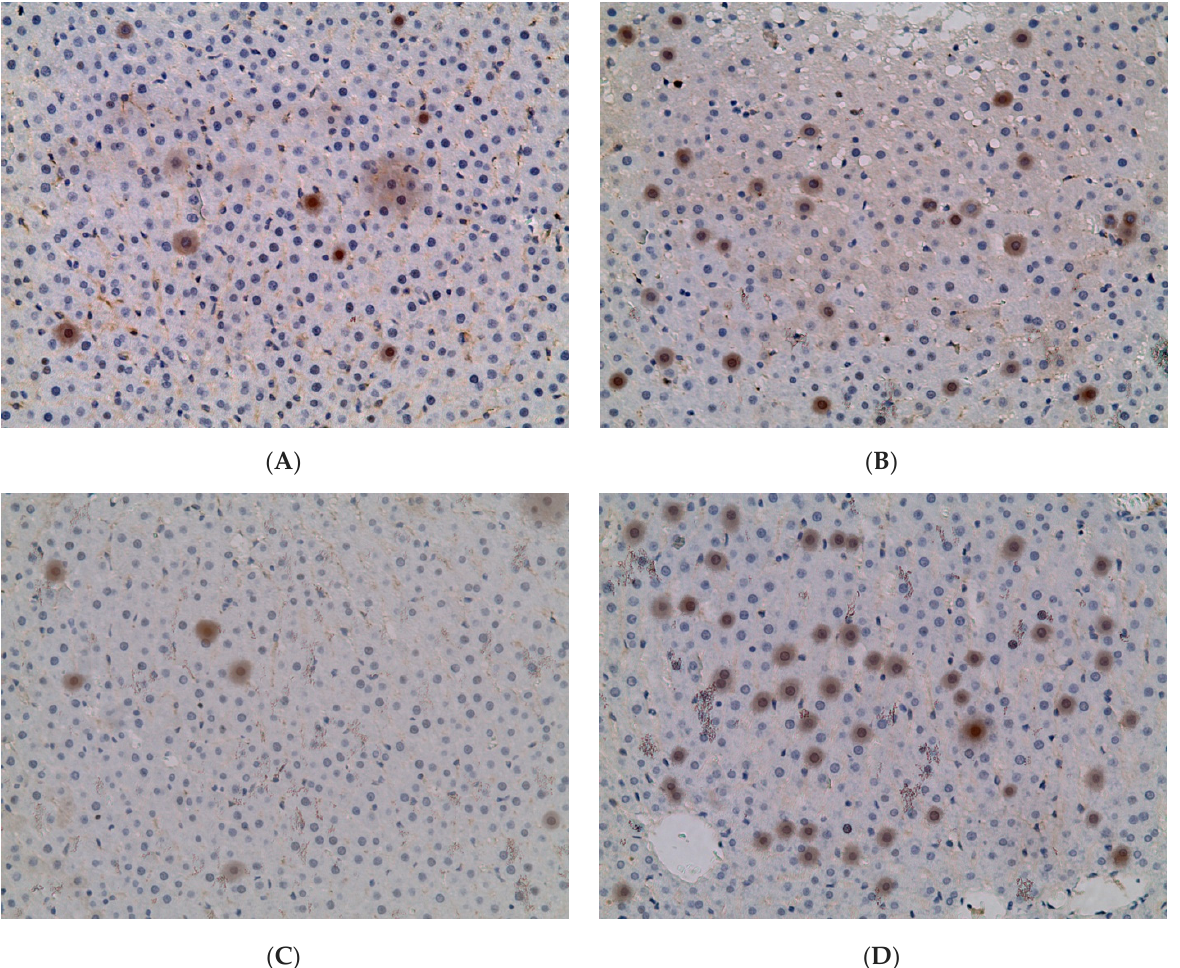
Figure 12. Expression of ADH5 in liver of rats. ( A )—Control; ( B )—EtOH; ( C )—CL; ( D )—EtOH + CL. ×200.